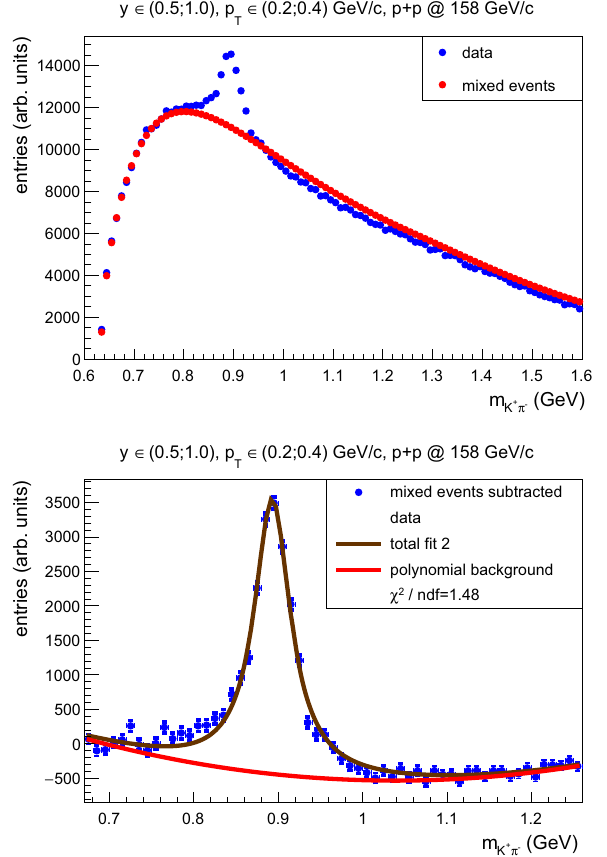
Figs. 4, 5 (bottom, right). One sees that the remaining back- ground (red curves) is much less significant than in the case of the standard method (Figs. 4, 5 (bottom, left)). In fact, a small residual background is present mostly for the y and p T bins in which the statistics is very low. To subtract it, a fit of the blue histograms was performed as the last step using the function Eq. (2). The results are shown in Figs. 4, 5 (bottom, right). The red lines ( polynomial background ) illustrate the remaining residual background (Eq. (2) without BW ) and the brown curves ( total fit 2 ) the sum of residual background and BW signal distribution (Eq. (2)). Finally, the uncorrected number of K ∗ ( 892 ) 0 mesons (for each separate y and p T bin) is obtained as the integral over the BW signal of total fit 2 in Figs. 4, 5 (bottom, right). The integral is calculated in the mass window m 0 ± 4 (cid:4) 0